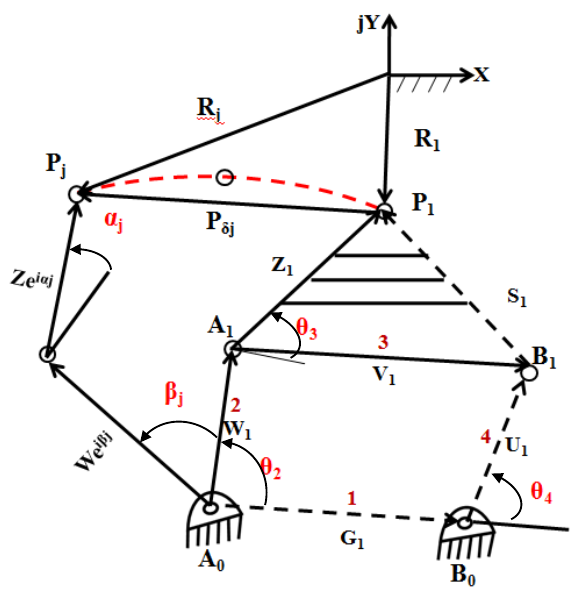
Figure 2. A schematic diagram of a four-bar mechanism for left dyad Three position analytical path generation synthesis procedure: The global coordinate